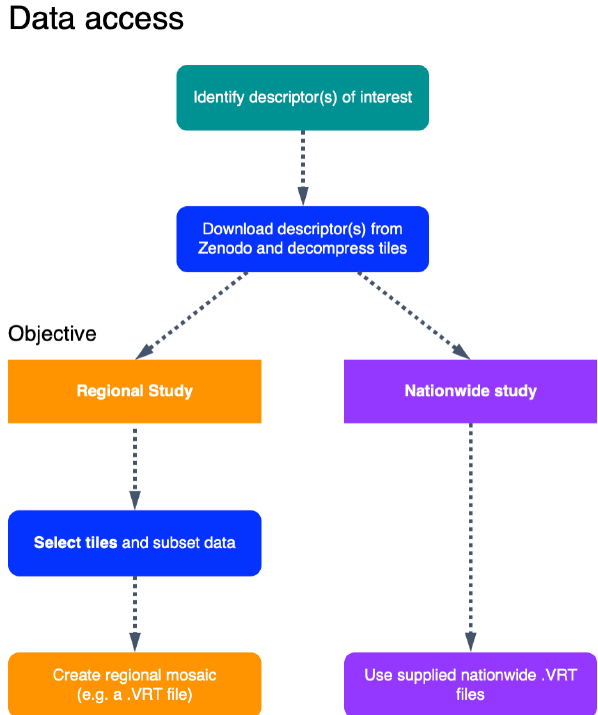
Figure 6. Schematic chart of two possible approaches for accessing and integrating EcoDes-DK15 data into ecological studies. The first step is to identify which descriptors are of interest; these descriptors can then be downloaded from the Zenodo repository and decompressed. Next a decision needs to be made whether the whole data set (nationwide) or only a subset of the tiles is required (e.g. a regional study). As the whole data set is relatively large ( ∼ 94GB), storage and processing limitations need to be taken into account when planning data processing and handling. If a subset of tiles is sufficient for a study, the provided tile footprints can be used to identify which tiles are required based on a geometry (e.g. a shapefile) of the study region(s). Finally, for easy data handling in subsequent analysis, a mosaic of the selected tiles can be created. For nationwide use we provided virtual mosaics (VRT files) containing all tiles for the descriptors. An R script illustrating how the subsetting can be done for a regional study can be found on the GitHub repository: https://github.com/jakobjassmann/ ecodes-dk-lidar/blob/master/manuscript/figure_7/subset_dataset.R (last access: 5 January